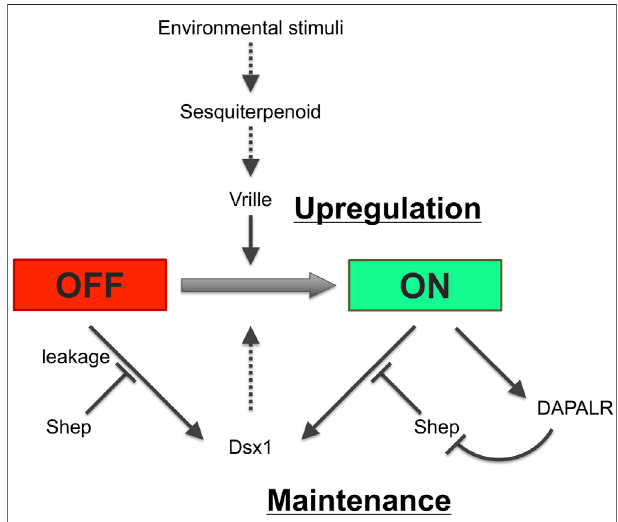
FIGURE 14 | Potential regulatory network for Dsx1 expression. Solid and dotted lines indicate validated and non-validated relationships by experiments. Figure inspiration was drawn from Huang et al.